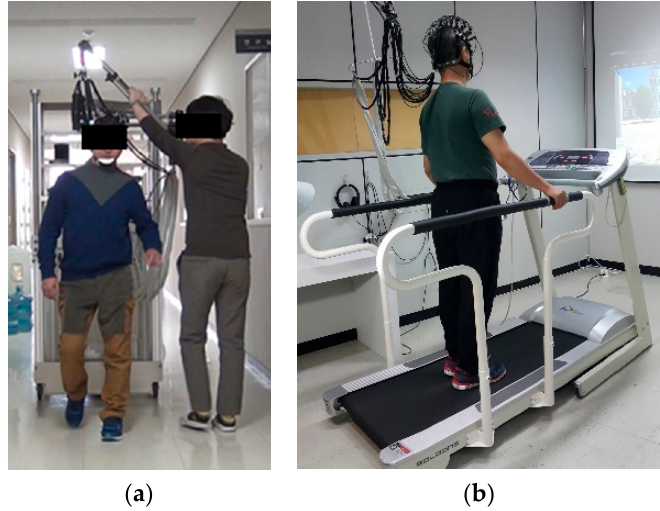
Figure 5. Actual experimental environment: ( a ) OG walking task; ( b ) TM walking task.